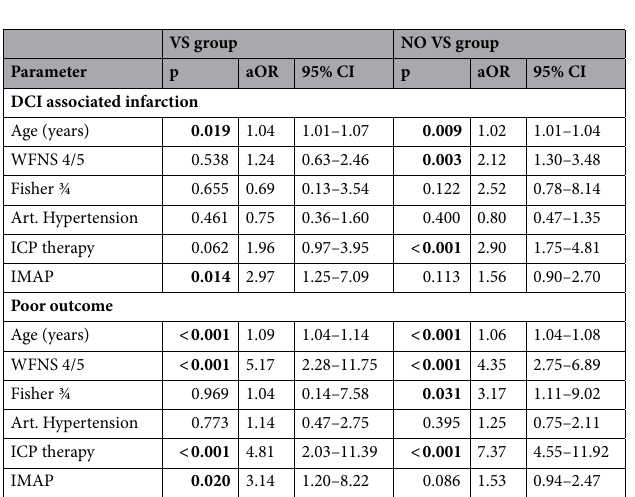
Table 2. Multivariate analysis for the influence of IMAP on poor outcome and DCI occurrence. Significant p-values are marked bold. 95% CI 95% confidence interval, DCI delayed cerebral ischemia, ICP intracranial pressure, IMAP increased mean arterial pressure, aOR adjusted odds ratio, (NO) VS (no) vasospasm, WFNS World Federation of Neurosurgical Societies.